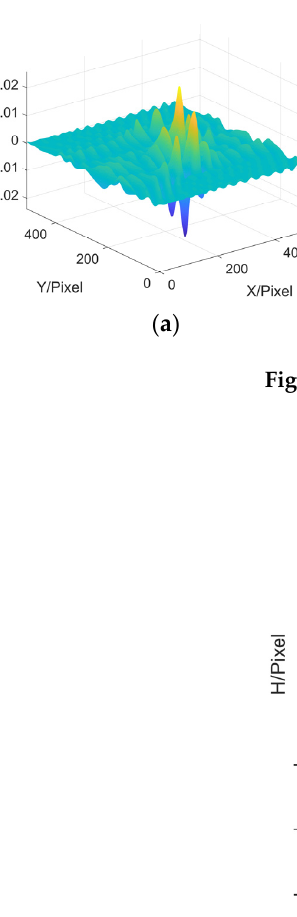
Figure 3. Simulation experiment results of peaks. ( a ) object; ( b ) deformed fringe pattern; ( c ) moire fringe pattern 1; ( d ) moire fringe pattern 2; ( e ) wrapped phase; ( f ) wrapped phase reconstruction result; ( g ) unwrapped phase; ( h ) unwrapped phase reconstruction result.